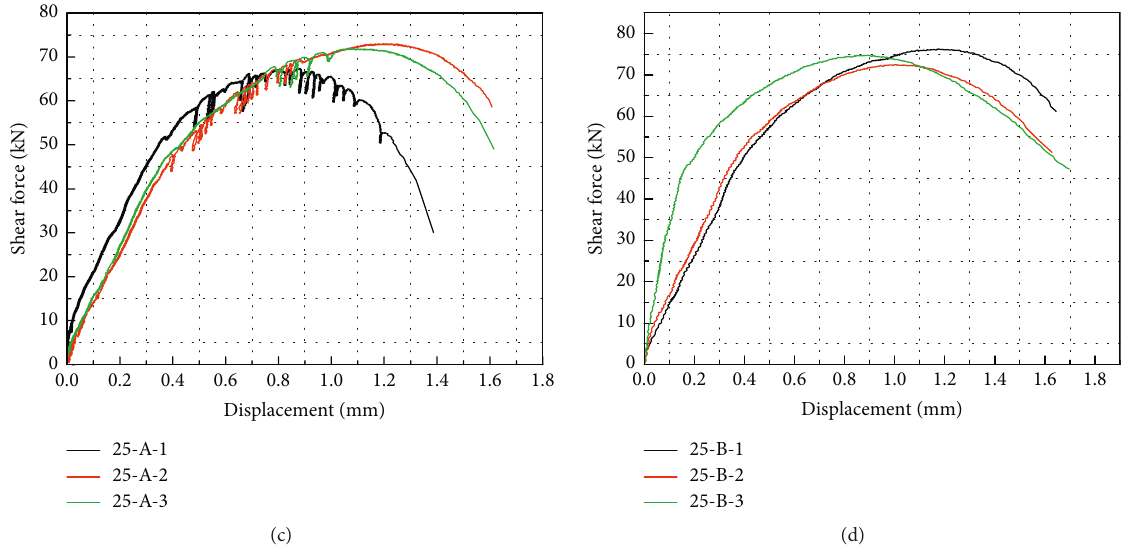
Figure 10: Pintle test curves. (a) φ 20: 0.01 mm/s. (b) φ 20: 1mm/s. (c) φ 25: 0.01mm/s. (d) φ 25: 1